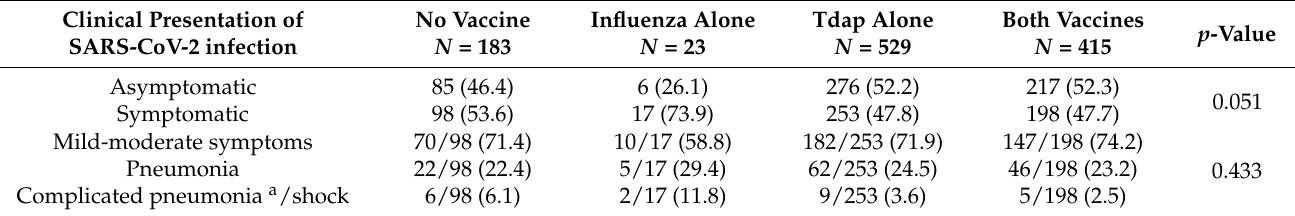
Table 2. Clinical presentation of SARS-CoV-2 infection by vaccination group.